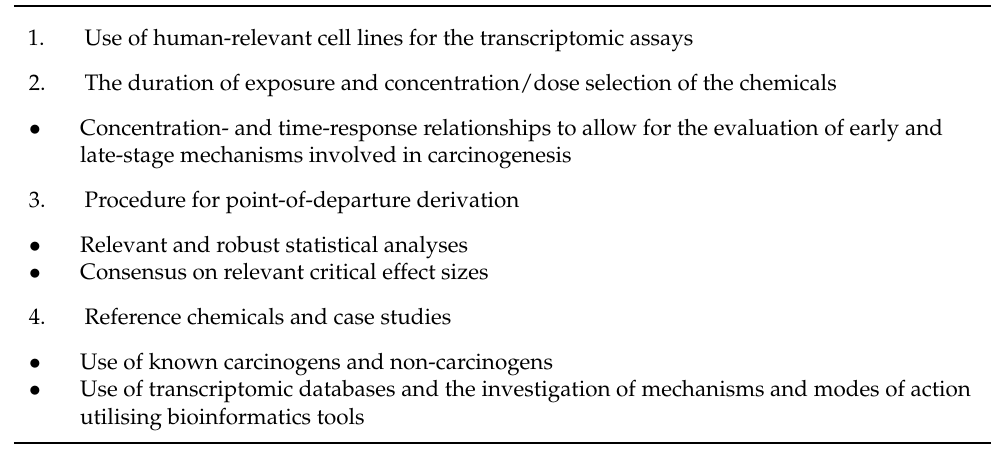
Table 3. Critical elements to include when designing transcriptomic testing